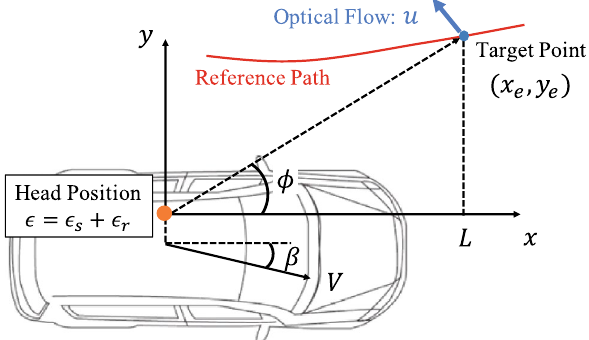
Figure 3. Vehicle coordinate. Optical flow affected by seat position and driver’s roll